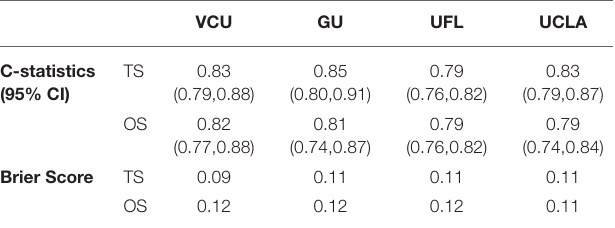
TABLE 3 | C-statistics and brier score comparison between the two-step method (TS) and direct one-step (OS) method.